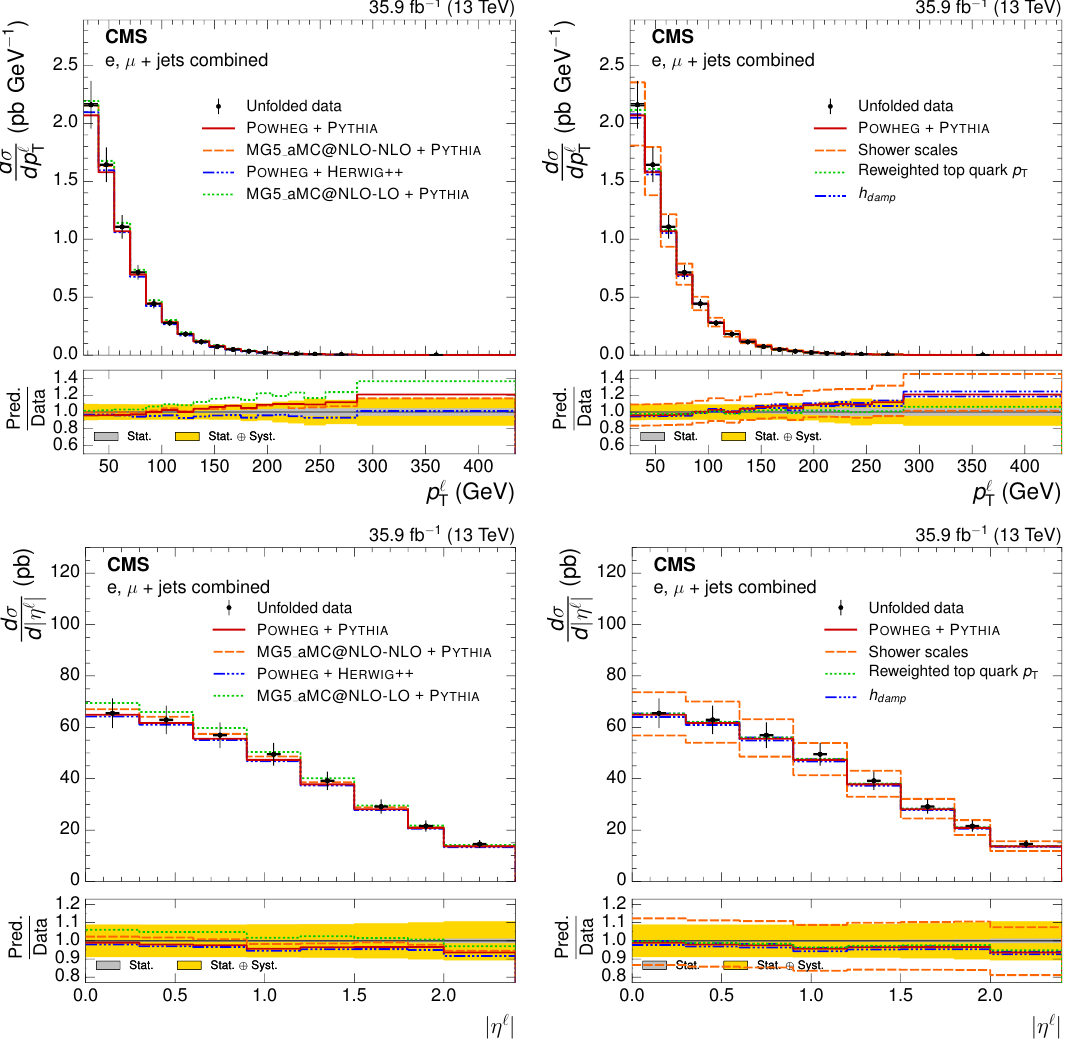
Figure 10 . Absolute p ‘ (upper) and (cid:17) ‘ (lower) di(cid:11)erential tt cross sections, compared to di(cid:11)erent T j j tt simulations in the left plots, and compared to the powheg + pythia simulation after varying the shower scales, and h damp parameter, within their uncertainties, in the right plots. The vertical bars on the data represent the statistical and systematic uncertainties added in quadrature. The bottom panels show the ratio of the predictions to the